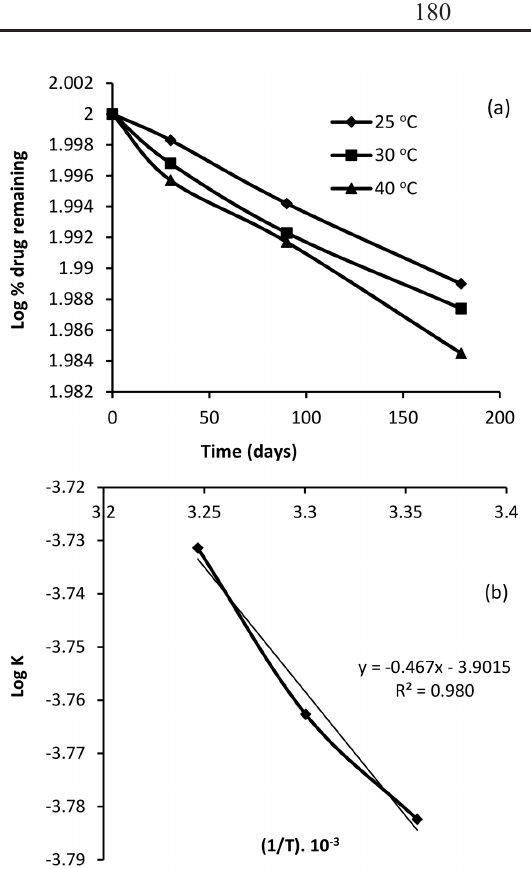
FIGURE 4 - (a) Log % drug remaining vs. time plot (b) Arrhenius plot for optimized HP-SLNs